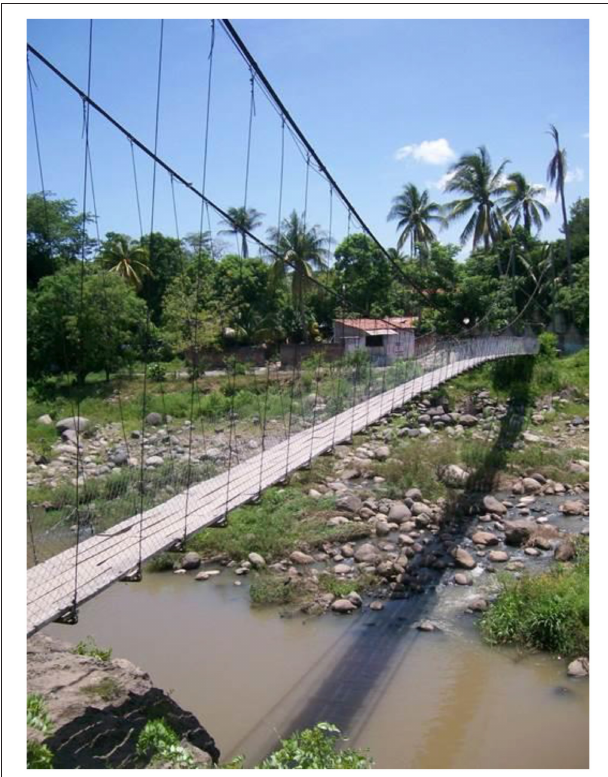
FIGURE 1 | An example of rural footbridge: Melara Footbridge, El Salvador (taken by the first author).